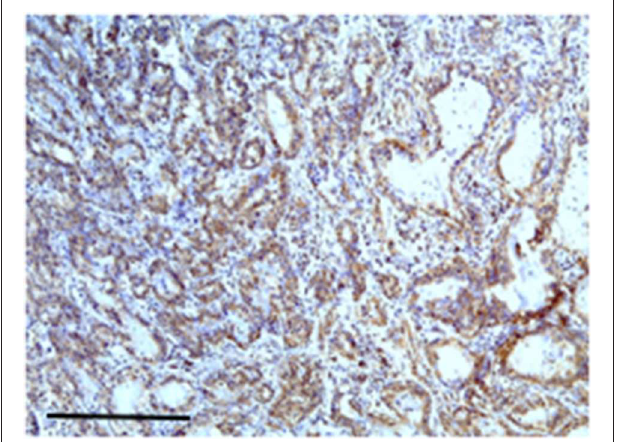
TABLE 4 | Percentage of subtypes of Carcinoma-Simple type.